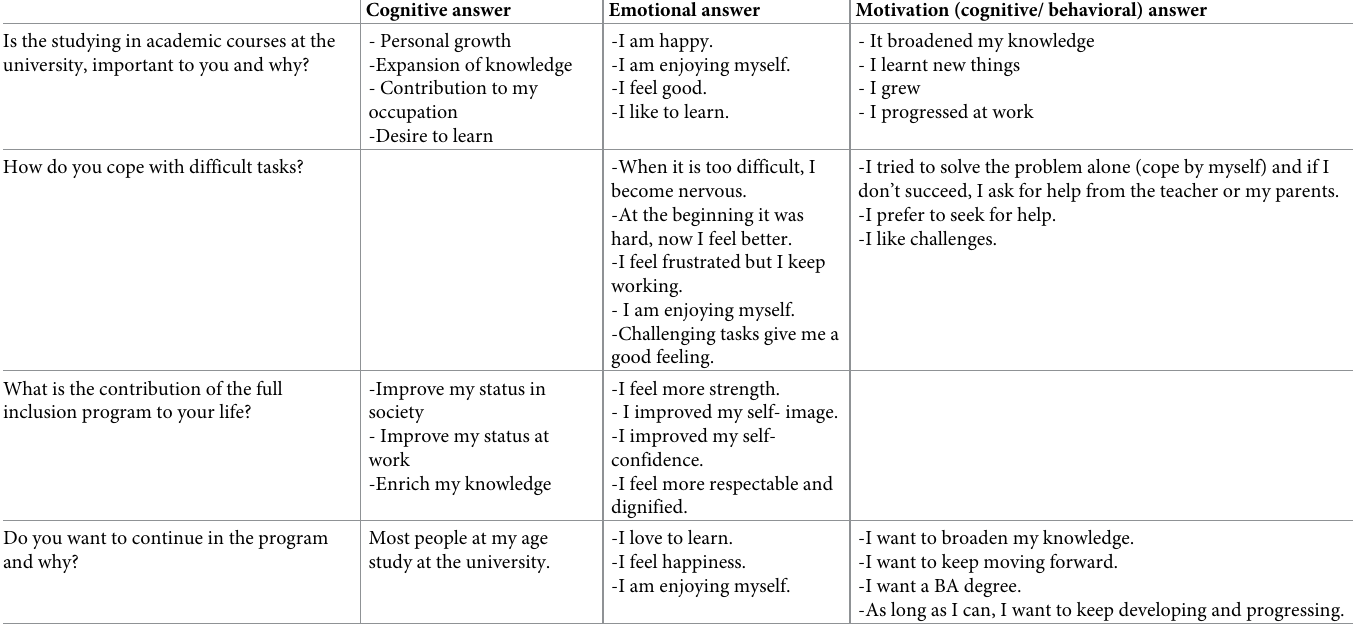
Table 6. Sample answers on the semi-structured